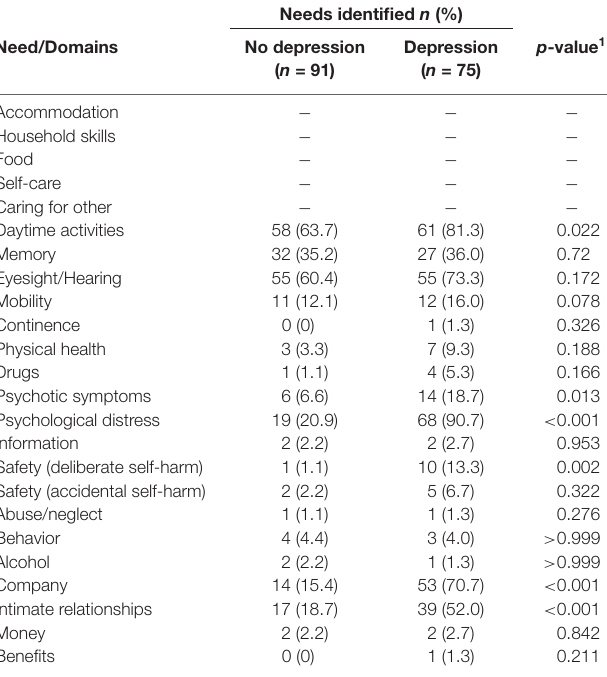
TABLE 6 | Unmet needs considering depressive symptoms